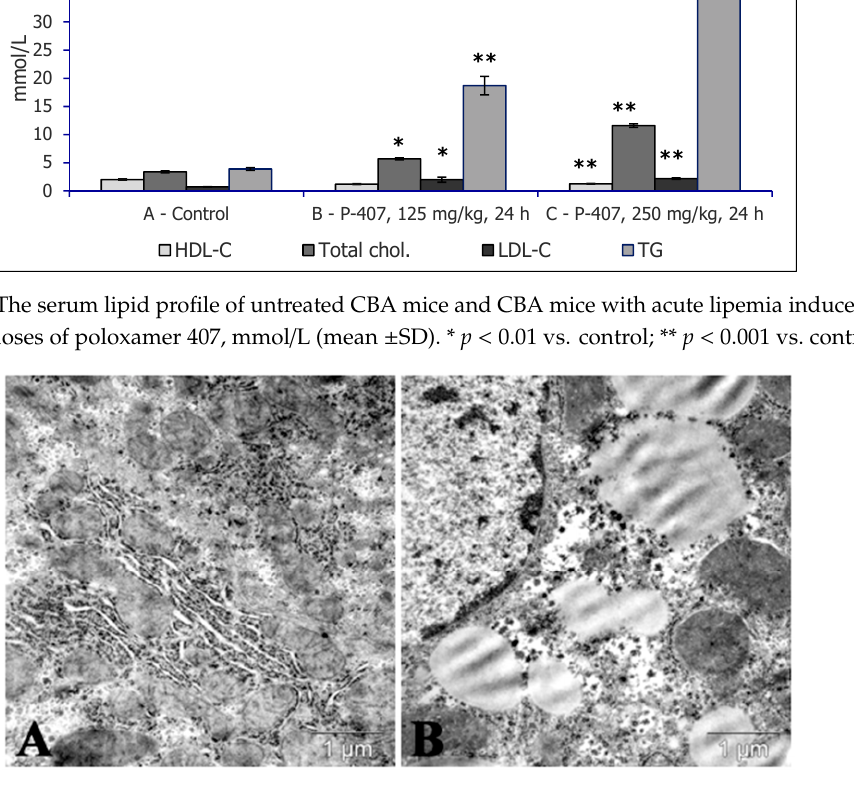
Figure 2. Lipid droplets in cytoplasm of mice hepatocyte in acute lipemia induced by the repeated administration of P-407 (300 mg/kg, twice per week during 30 days. ( A ) Control; ( B ) 24 h after the last administration of P-407.